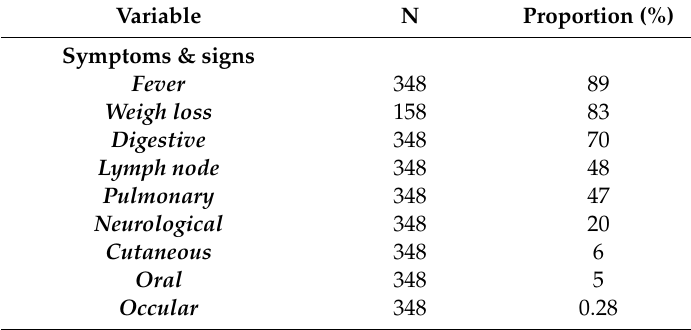
Table 1. Symptoms and signs for HIV-associated disseminated histoplasmosis. 1981–2014, French